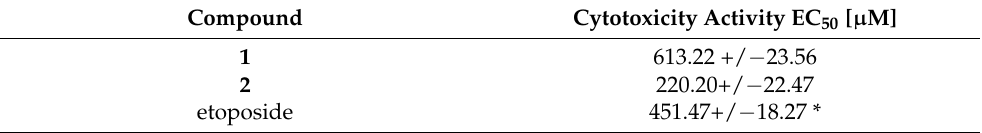
Table 4. Cytotoxicity activity at the EC 50